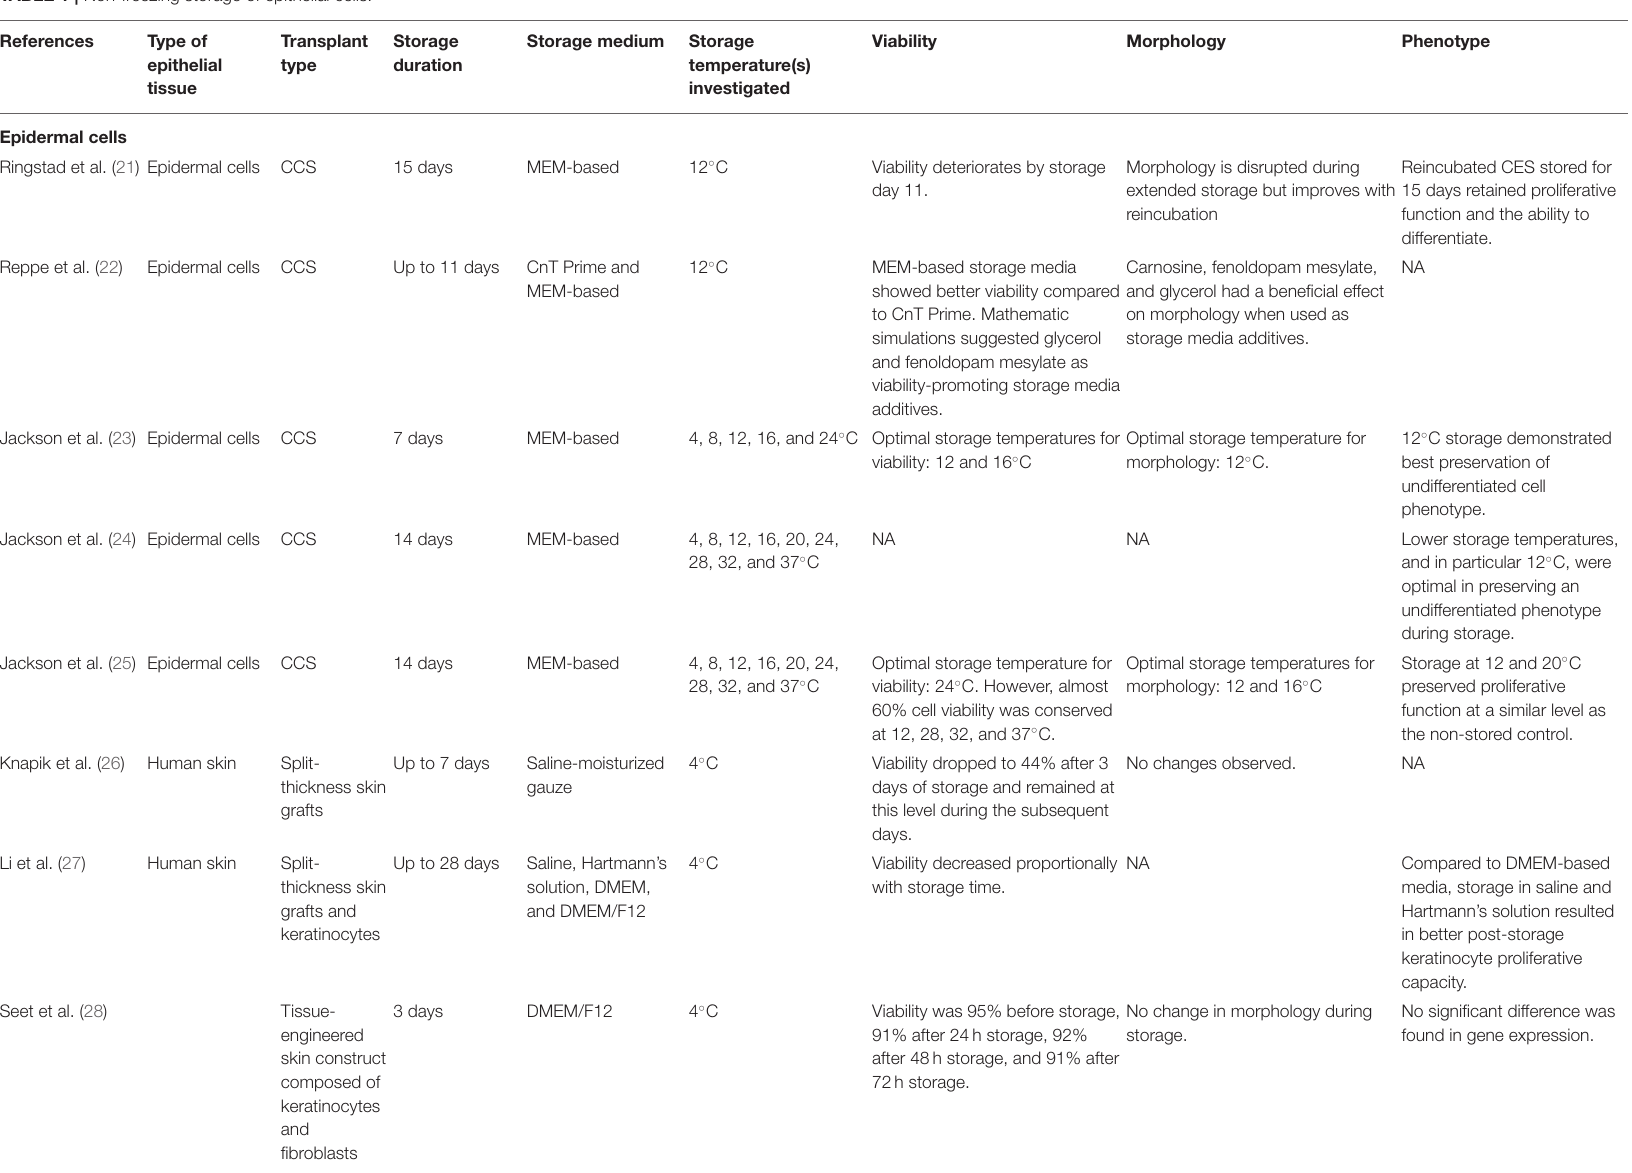
TABLE 1 | Non-freezing storage of epithelial